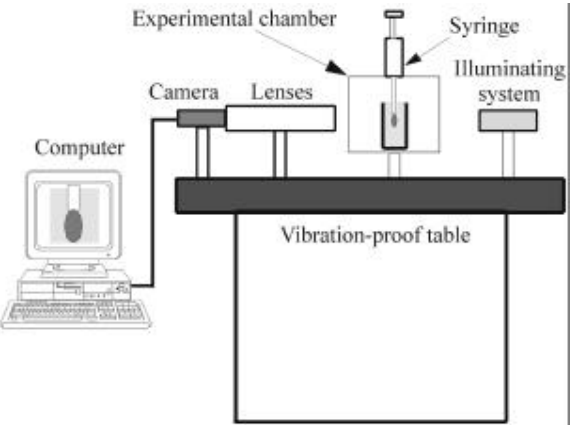
Figure 2. Pendant drop